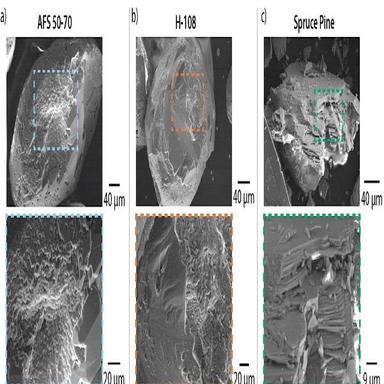
Typical examples of sand grain surface features and roughness. (a) AFS 50–70, (b) H-108, (c) sieved quarry sand. (SEM images, 15 kV).